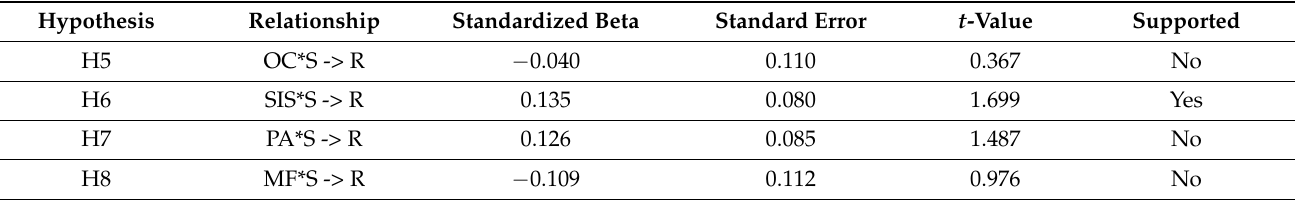
Table 14. Outcome of the tested interactions.